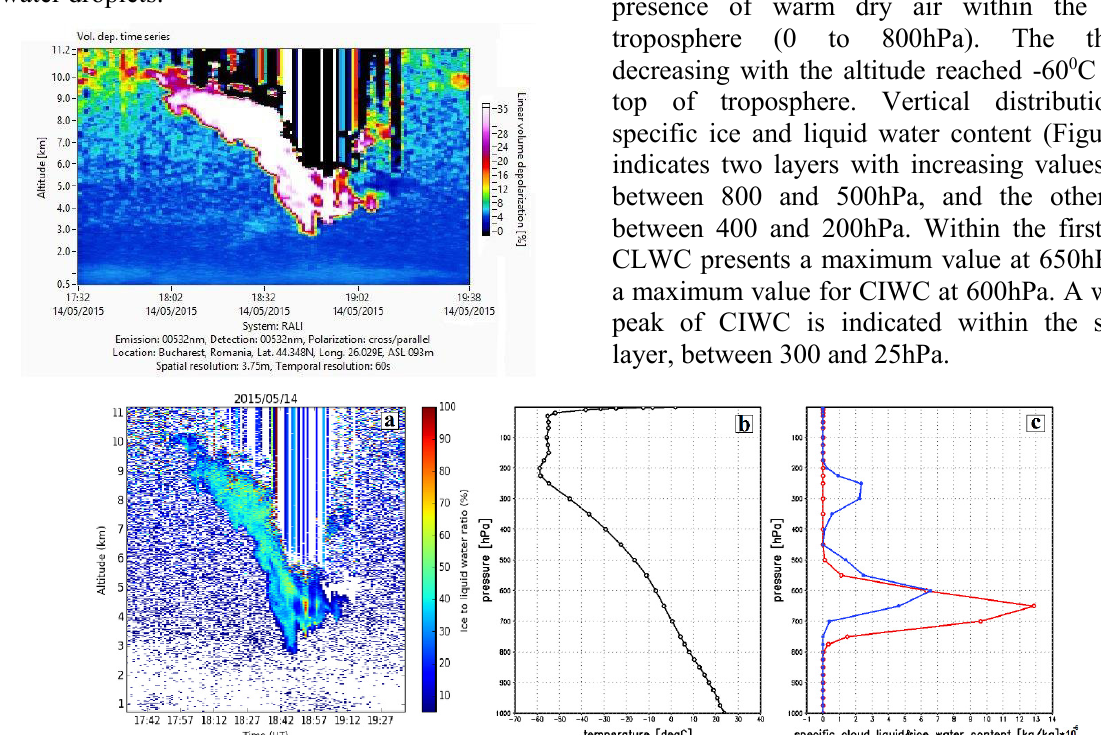
Figure 4 Time series of ice to liquid water ratio from lidar measurements (a) profile of T 0 C (b) and CIWC (blue line) & CLWC (red line) (c) from ECMWF ERA - Interim reanalysis for May 14, 2015 [18TC]